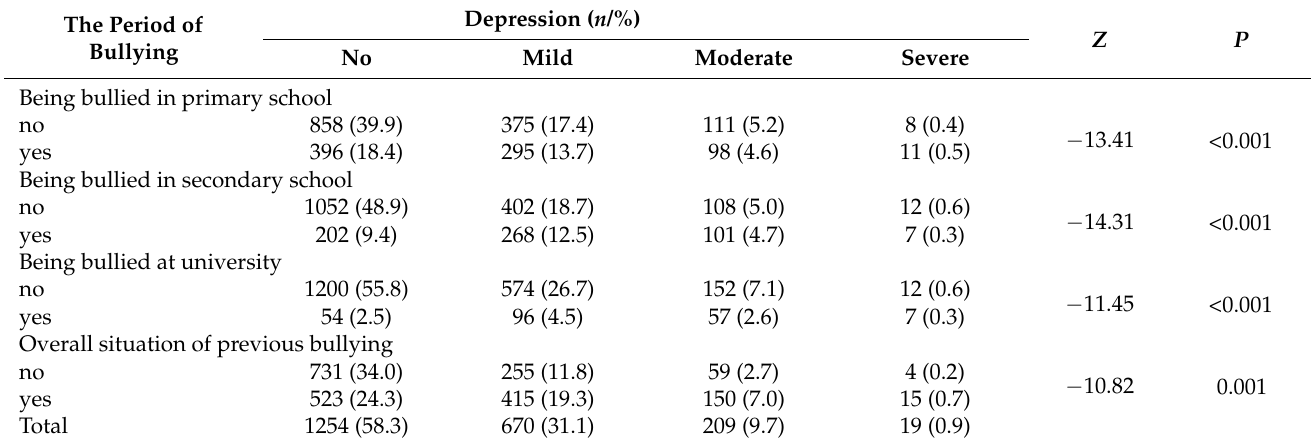
Table 2. Analysis on the differences of categorical variables between bullying and depression.